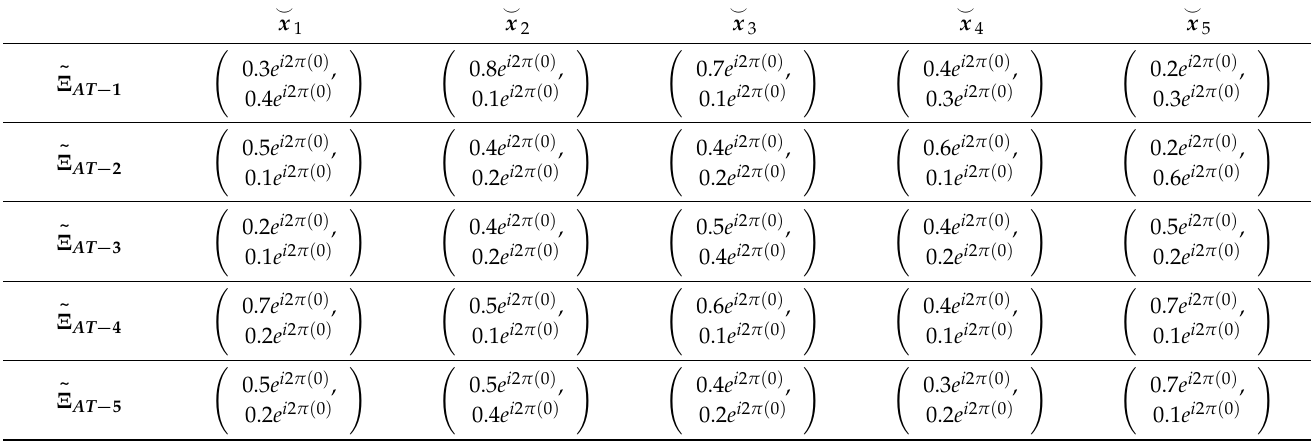
Table 10. Original decision matrix for candidates (cid:101) Ξ CI − 4